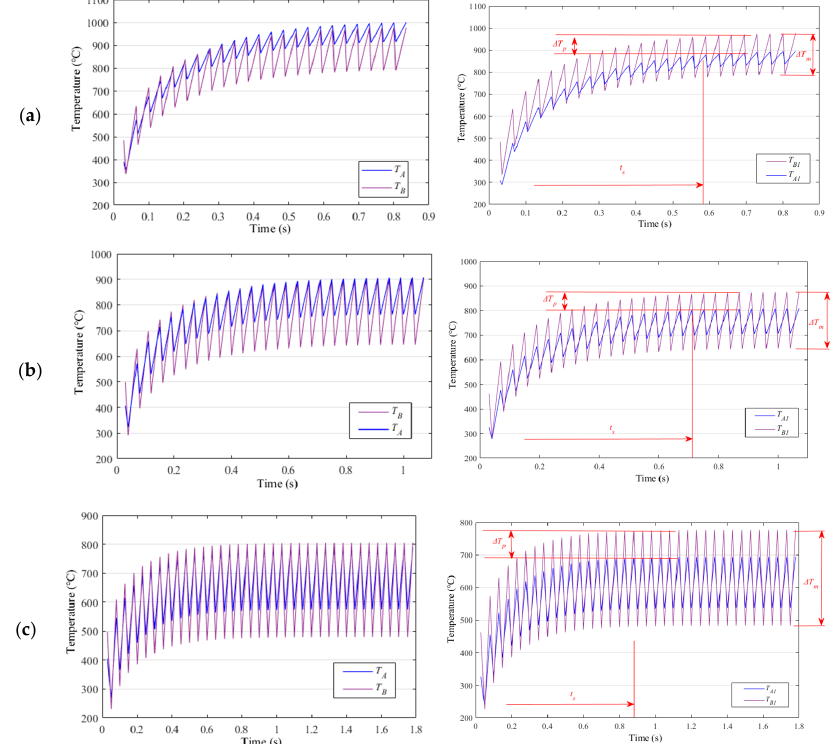
Figure 4. Temperature history at sampled points at various pulse periods, 𝑡 (cid:3043) ( a ) 0.035; ( b ) 0.040 and ( c ) 0.050 s. ( c ) 0.050